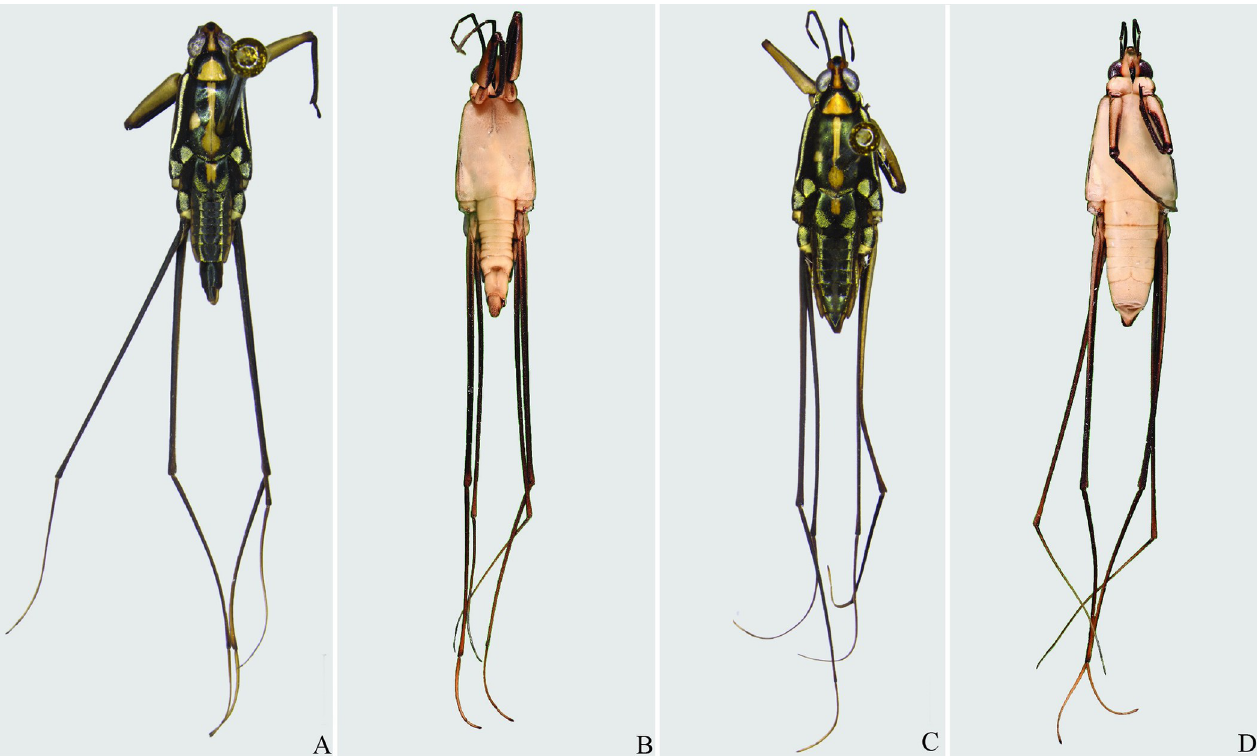
Fig 24. Potamobates unidentatus . (A) Male, dorsal view; (B) male, ventral view; (C) female, dorsal view; (D) female, ventral view.